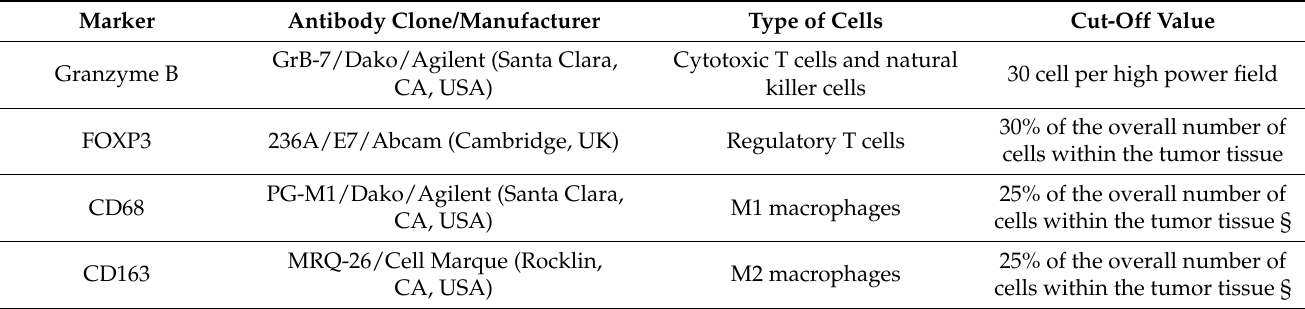
Table 1. Analyzed cell markers, antibodies used for their detection on cells of a specific type and cut-off values for each